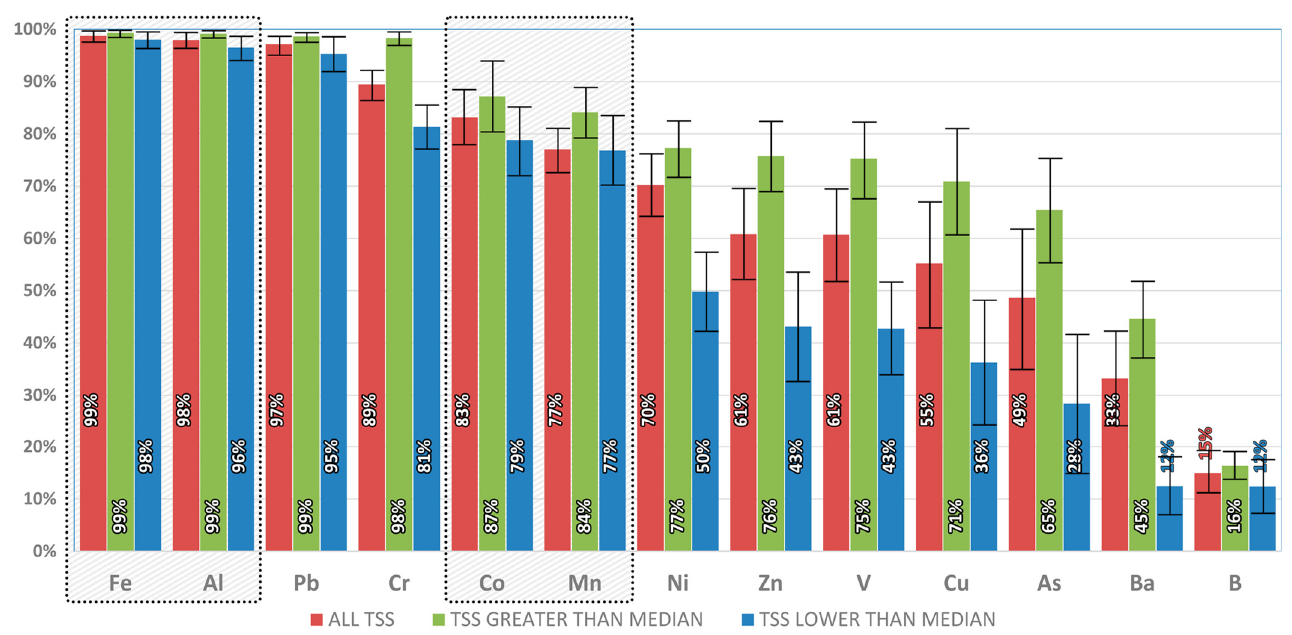
Figure 3. Percentage of HMs associated with particulate fraction during higher (green) and lower energy (blue) runoff events. In the boxes, the surrogate HMs identified during the higher (green) and lower energy (blue) runoff events.